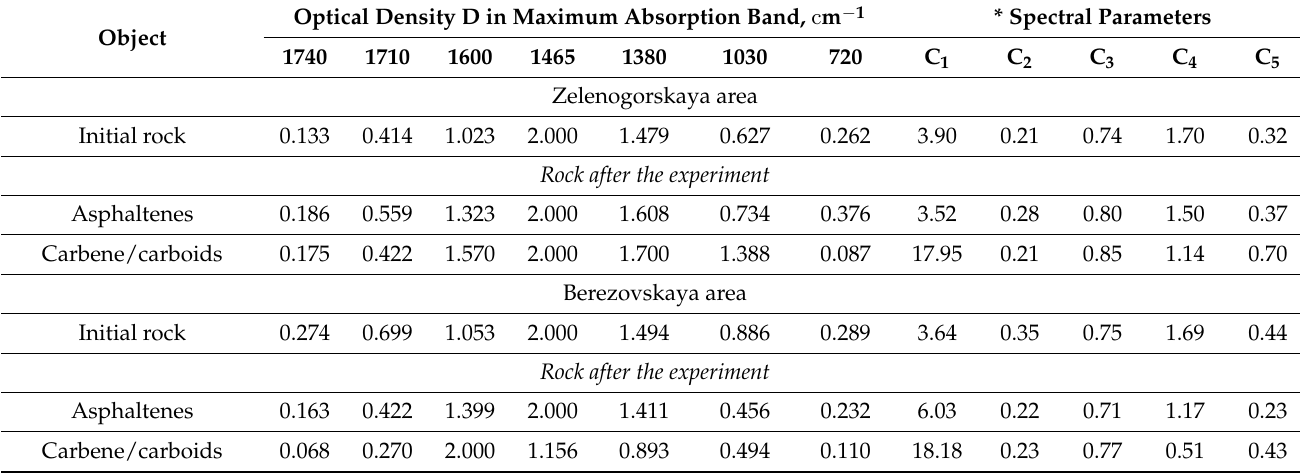
Table 3. Spectral parameters of asphaltenes, carbenes and carboids for the asphaltenes of Domanic rock samples before and after the hydrothermal experiments. Object